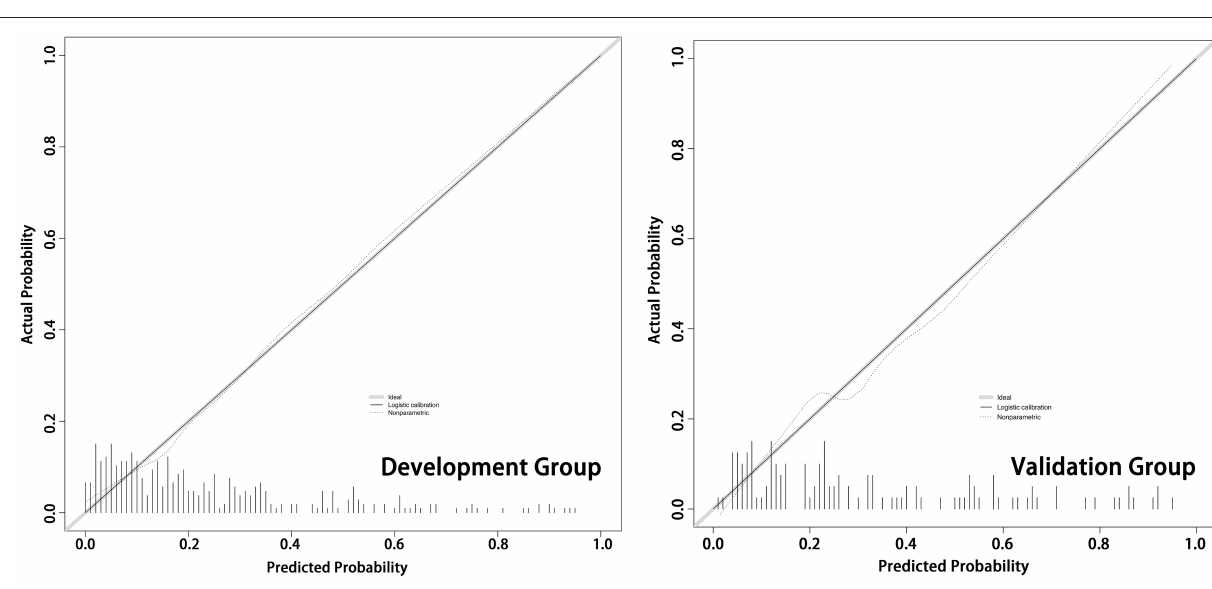
FIGURE 5 | The calibration plots of the development cohort and validation cohort. As shown in the calibration plots, the predicted probability of the model is plotted on the x-axis; the actual overall event is plotted on the y-axis. The higher the degree of overlap between the predicted curve and the diagonal (actual situation), the more accurate the